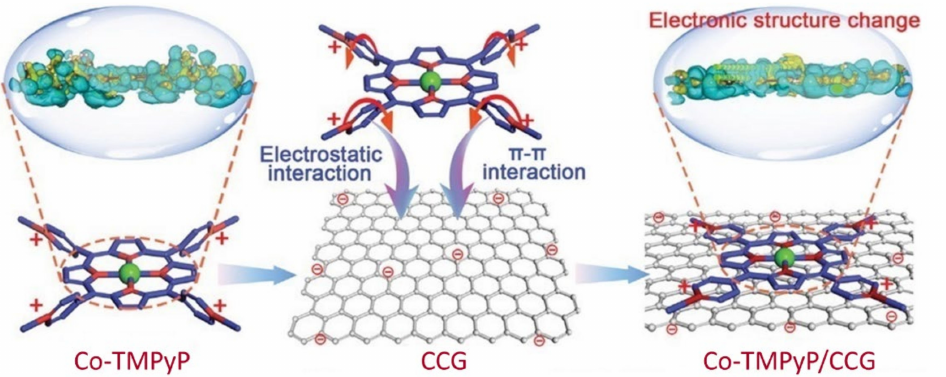
Figure 15. Schematic illustration of supramolecular assembly of Co-TMPyP on CCG. Reprinted with permission from ref. [93]. Copyright 2021 Wiley Online